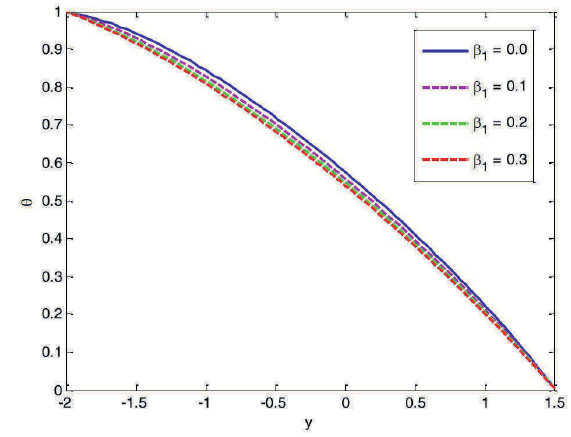
Fig. 11: Impact of porosity parameter K on temperature.